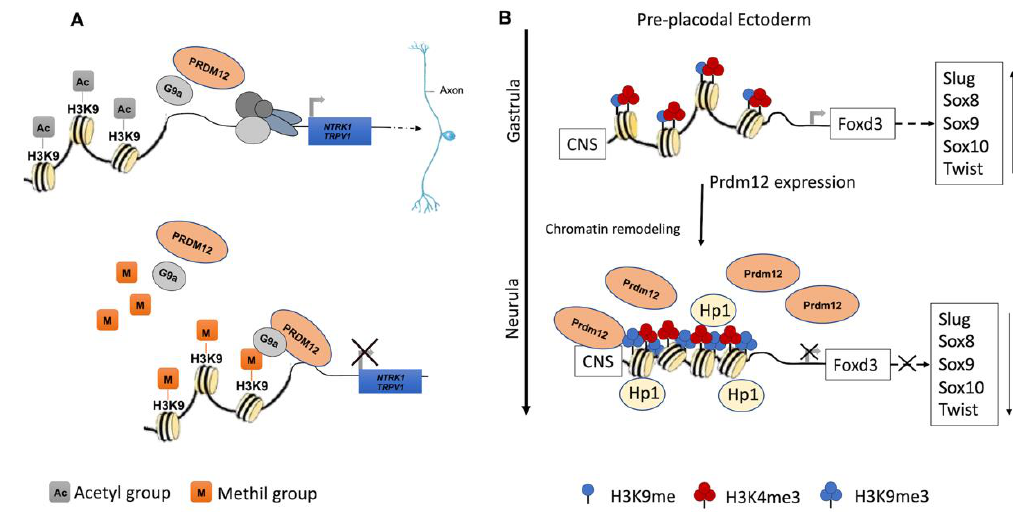
Figure 2. Recognized PRDM12 functions in neurogenesis. ( A ) PRDM12 lacks an intrinsic HKMTase activity, and it recruits, through its second zinc finger domain, the H3K9 methyltransferase G9a to dimethylate histone H3 at lysine 9 (H3K9me2), a repressive transcriptional mark. Particularly, PRDM12 regulates a nociceptor-specific transcriptional program, such as NTRK1/TRPV1. ( B ) In the pre-placodal ectoderm, PRDM12 is expressed and specifically stimulates the trimethylation of histone H3 at lysine 9 (H3K9me3) on the Foxd3 promoter to bind a conserved noncoding sequence (CNS). Additionally, Prdm12 inhibited the expression of different neural crest markers (Slug, Sox8, -9, -10 and Twist). A chromatin remodeling factor, HP1, recognizes the trimethylation of H3K9me3 and recruits other factors to convert euchromatin to heterochromatin.